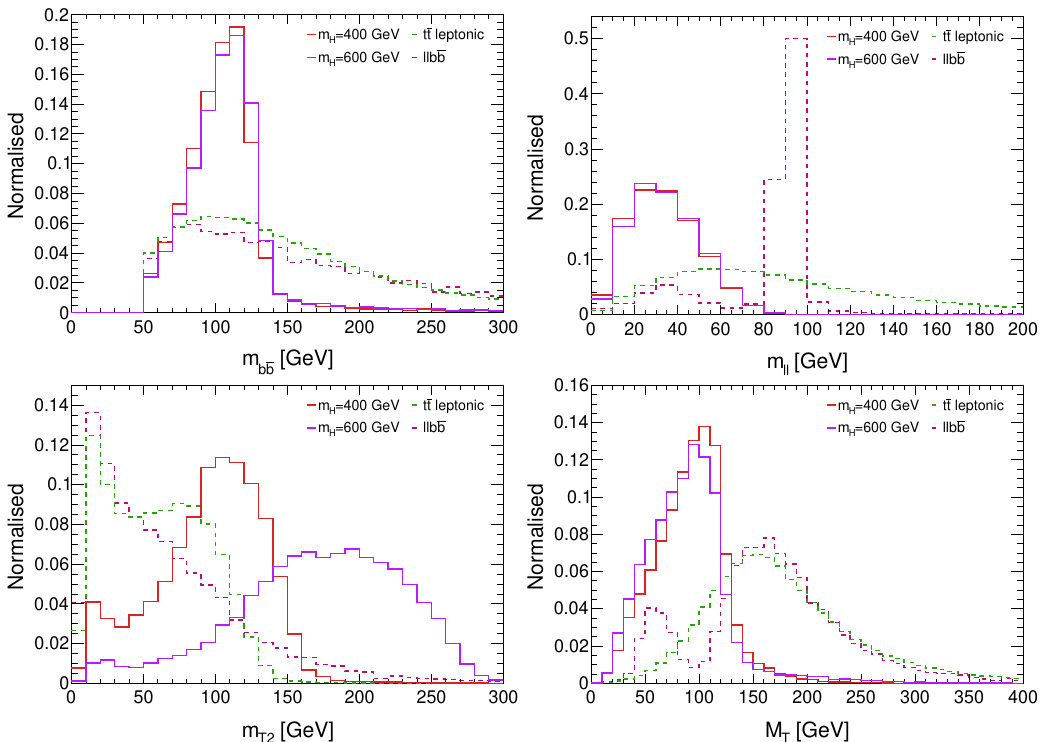
Figure 19 . The m bb , m ‘‘ , m T 2 and M T distributions for the 2 ‘ category for m H = 400 and 600 GeV with dominant backgrounds. Here the heavy Higgs boson is searched for in the b (cid:22) bWW (cid:3) channel. The distributions are shown before the multivariate